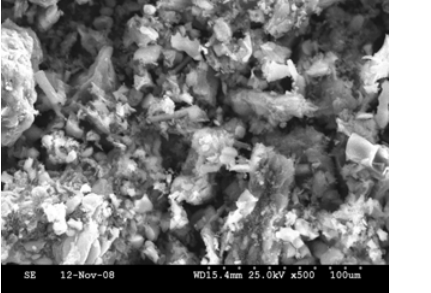
Figure 12b. SEM images for the adsorption of copper ion onto